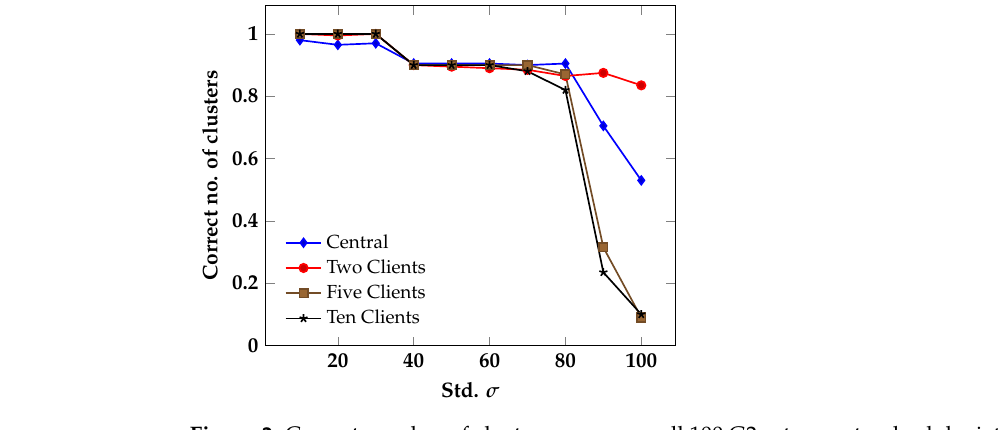
Figure 2. Correct number of cluster guesses on all 100 G2 sets per standard deviation σ . The values are averaged over all dimensions and runs. We observe a decline of correct number of cluster guesses with increasing σ . The figure shows results of the k -means averaging, but they are similar with federated averaging.